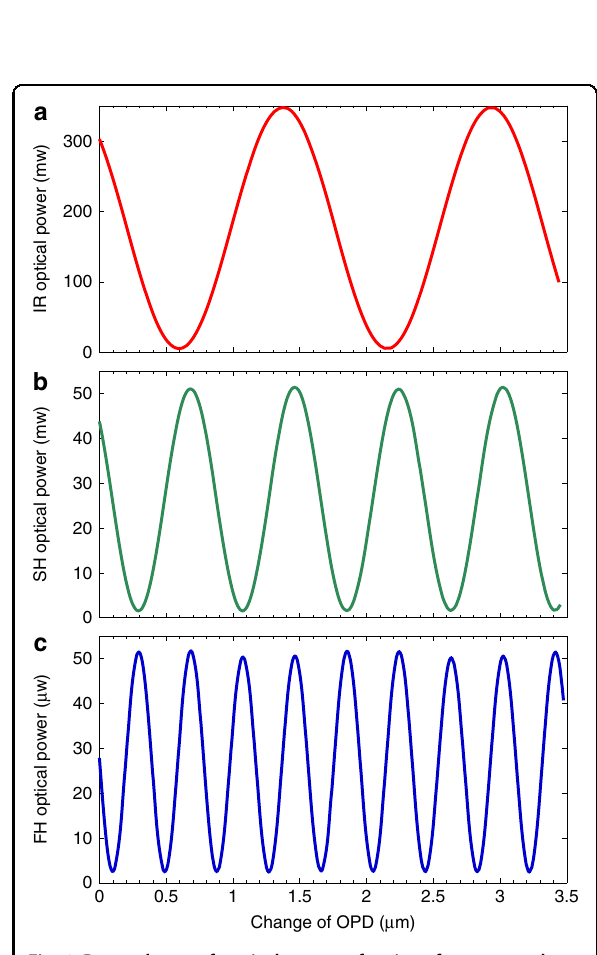
Fig. 3 Dependence of optical power after interference on the change in OPD. a Fundamental light; b SH light; c FH